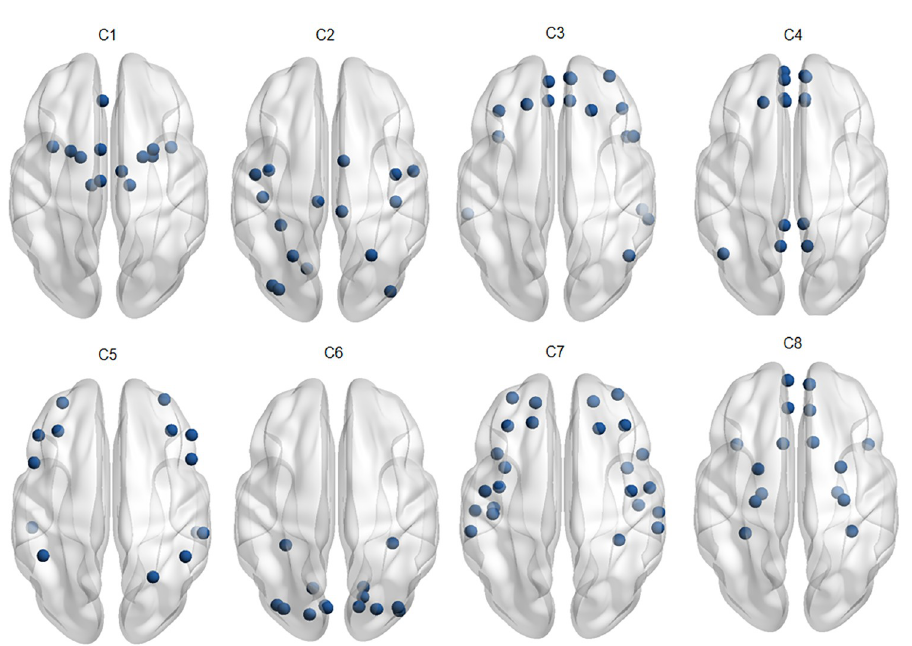
Fig 4. Overlapping communities derived from CORR. This figure displays the communities derived using CORR based matrix via thresholding of matrix P obtained with NMF ( K = 8).